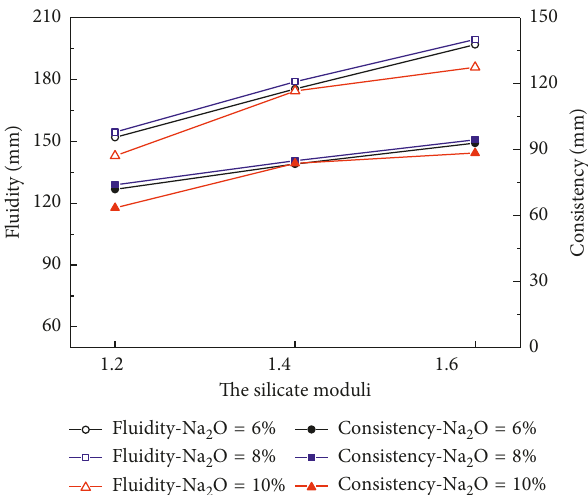
Figure 6: The effects of silicate moduli and Na fluidity and consistency of AAS mortars.